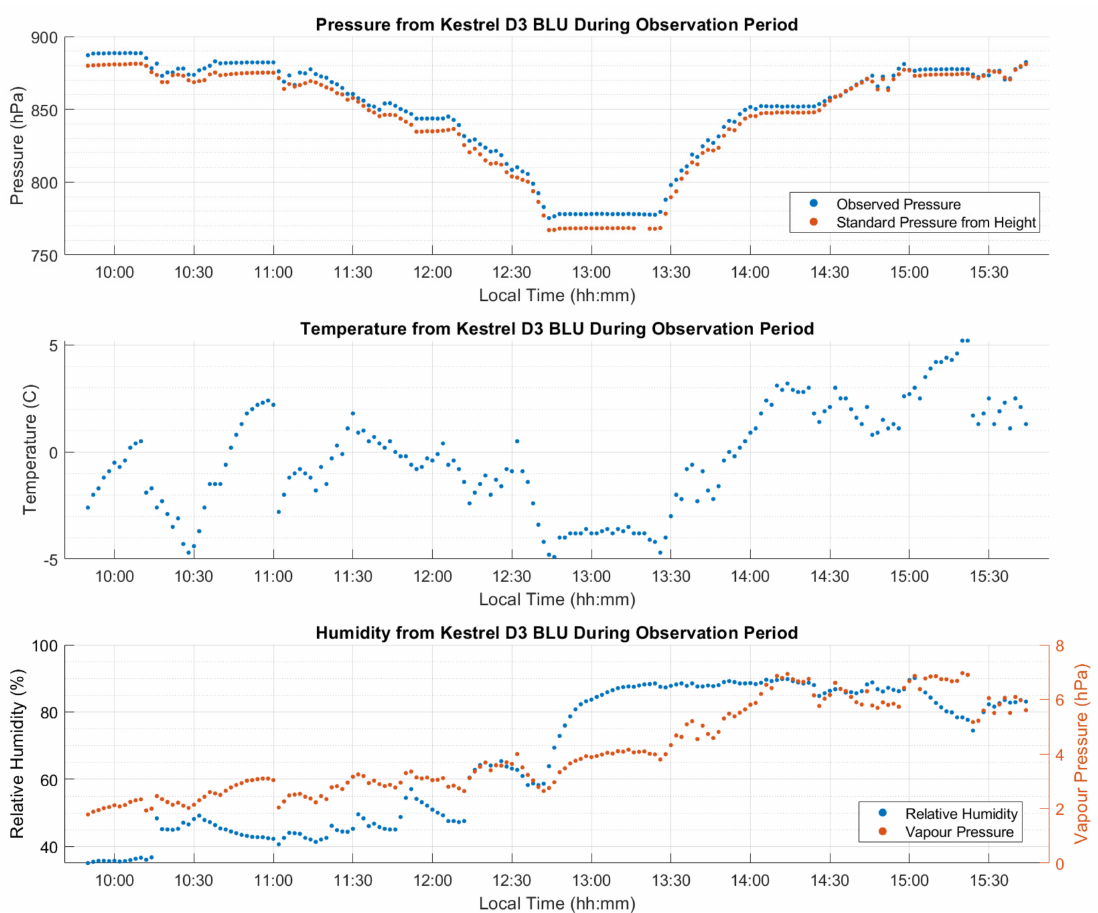
Figure 12. Kinematic dataset B atmospheric measurements made on the vehicle during the test. Measured atmospheric pressure was 5 to 10 hPa higher than standard pressure. Water vapour increased by some 4 hPa during descent due to changing weather conditions. Local time is UTC − 6:00.